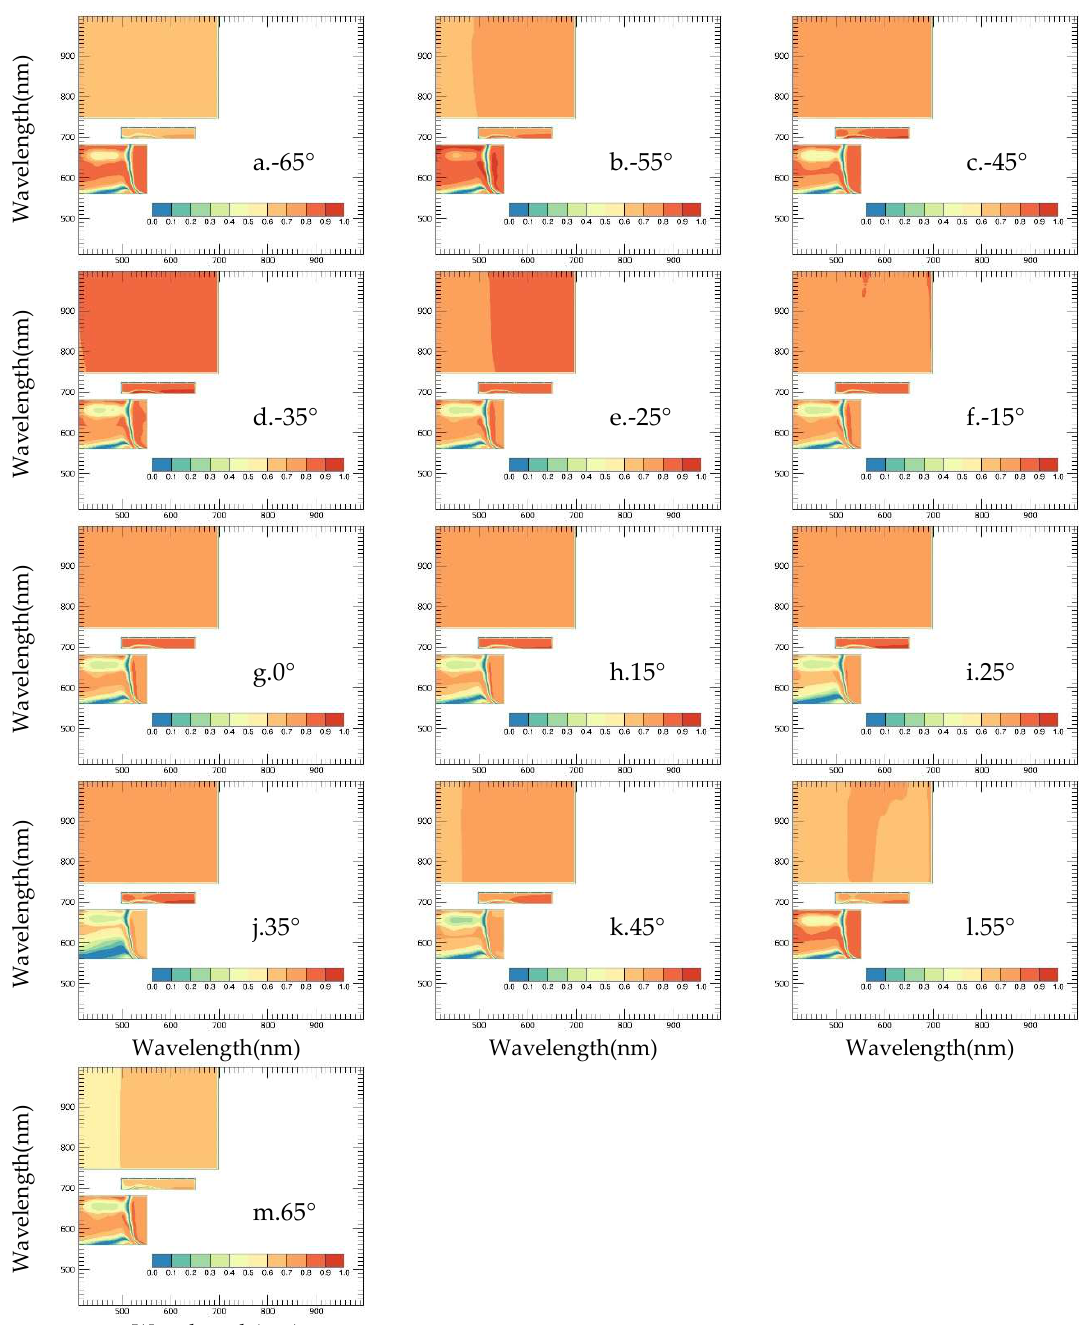
Figure A3. Contour maps of R 2 between NDSI(x,y) and LAI for thirteen VZAs in PP for the planophile variety based on PROSAIL simulations. Subtitle a.-m. shown in each graph denotes observation angle.